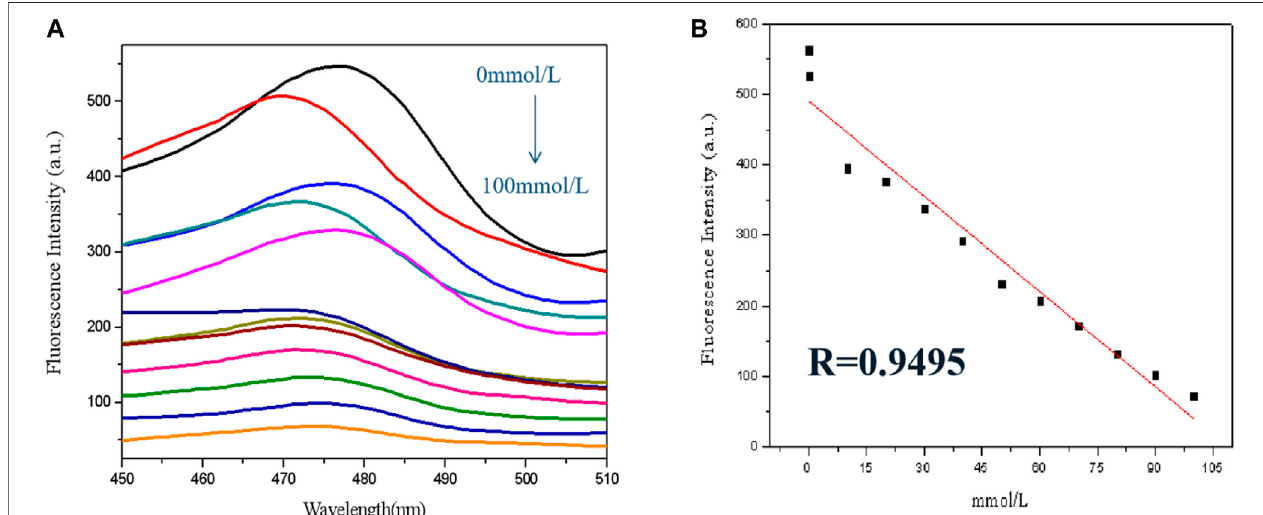
FIGURE5|(A) GSH-CuNP fl uorescencespectrawithdifferentconcentrationofbismuthions; (B) linearrelationshipbetween fl uorescenceintensityofGSH-CuNPs and concentration of Bi 3+ .